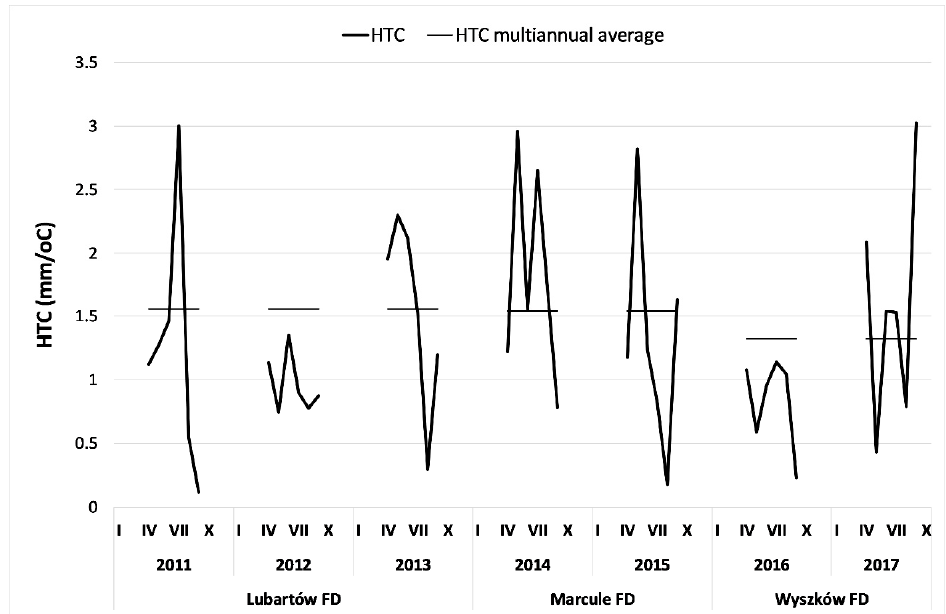
Figure 3. Monthly values of the hydrothermal coefficient (HTC) for research areas (source data: Institute of Meteorology and Water Management Bulletin).